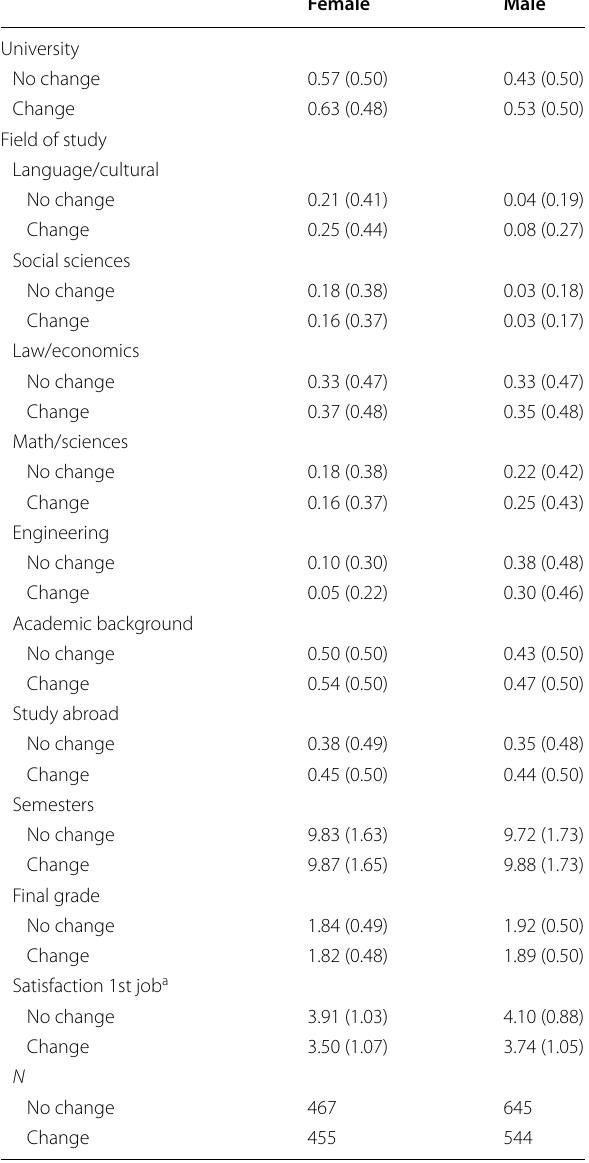
Table 2 Time-constant sample characteristics by gender and employer change. Source BAP 2005/06, author’s calcu-